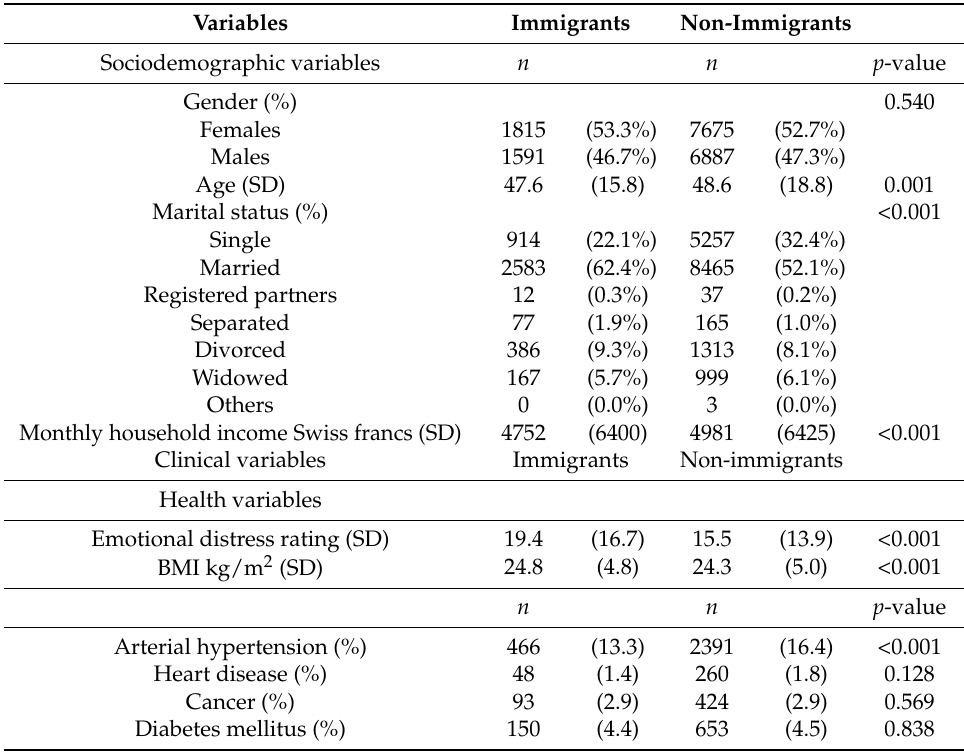
Table 1. Characteristics of study participants by immigration status.